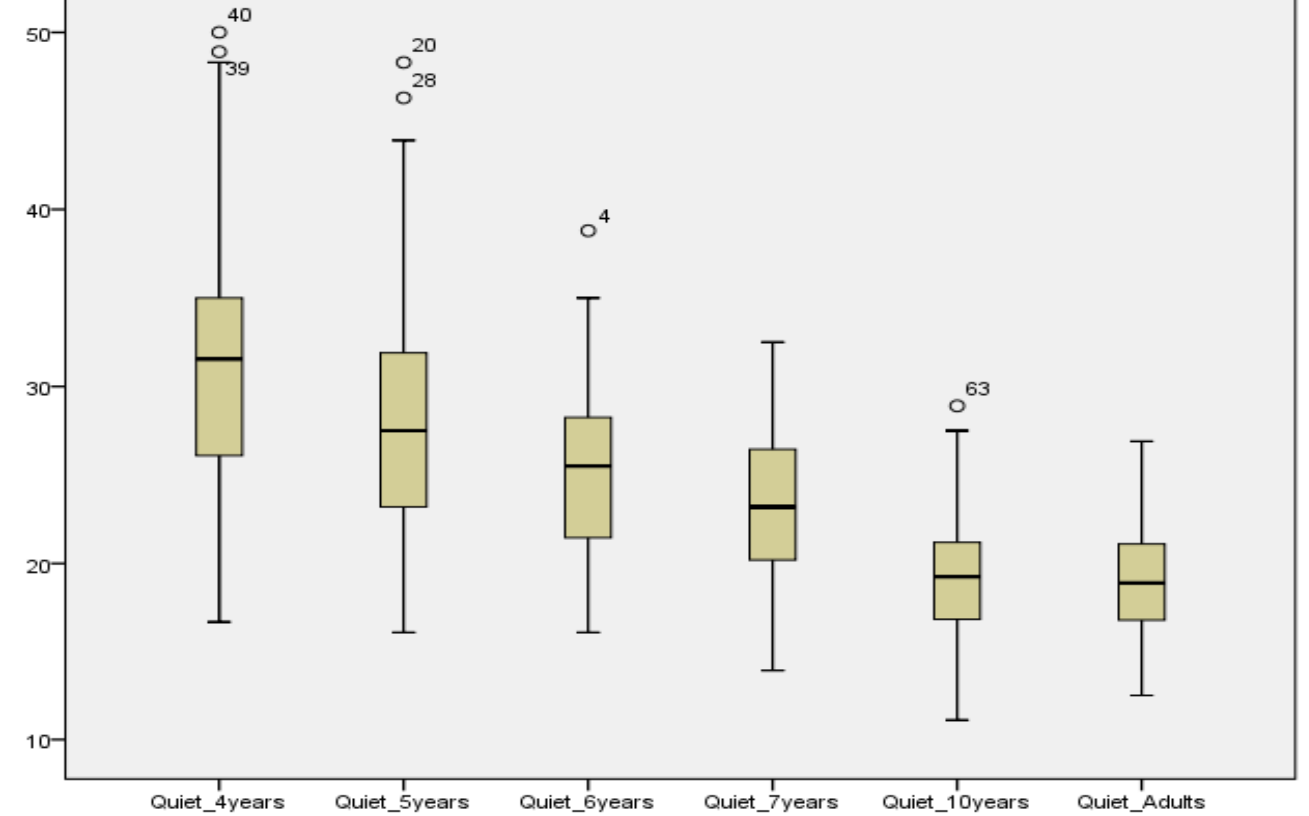
Figure 8. Comparison of mean SRT values in noise across age groups.